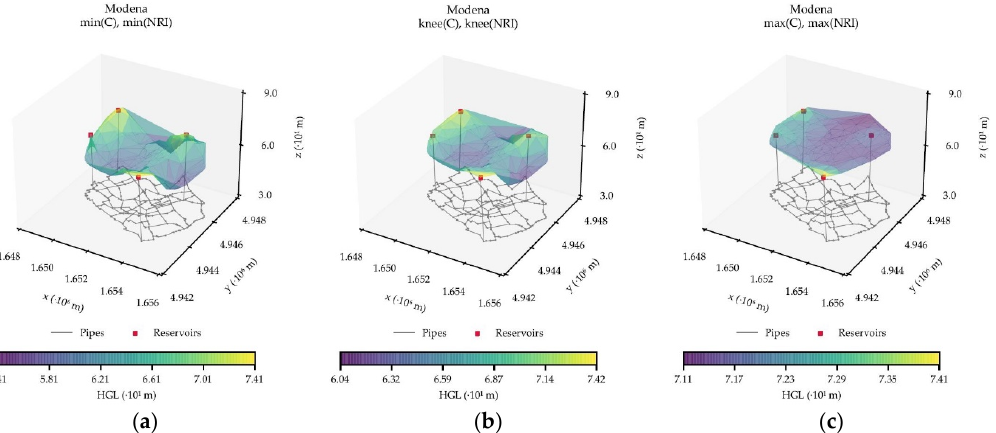
Figure 6. Modena WDS with the corresponding HGL surfaces for the: ( a ) [min( C ), min( NRI )]; ( b ) [knee( C ), knee( NRI )]; and ( c ) [max( C ), max( NRI )] configurations.